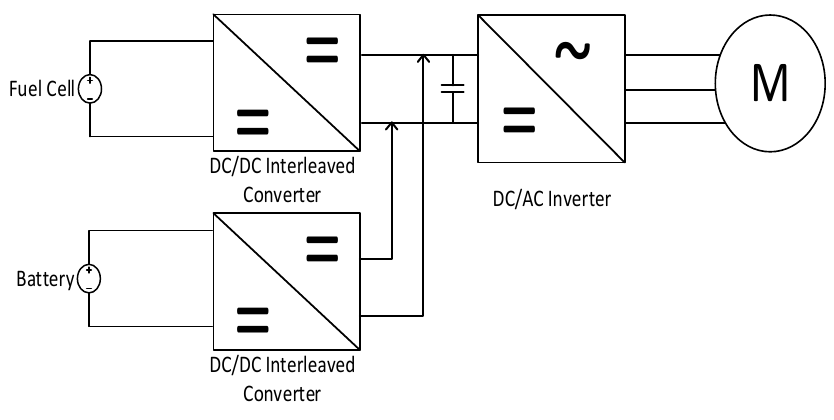
Figure 6. Fuel cell–battery hybrid traction [19].